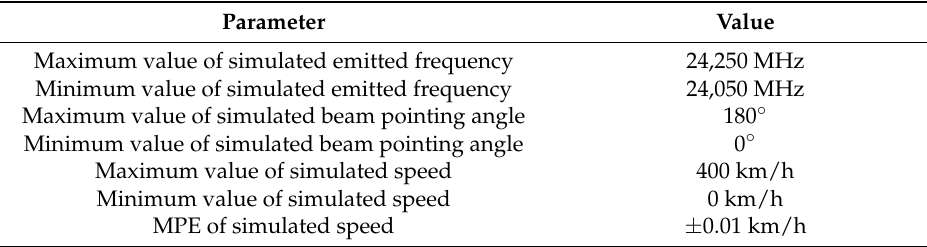
Table 3. Main parameters of dual Doppler shift simulation system for the